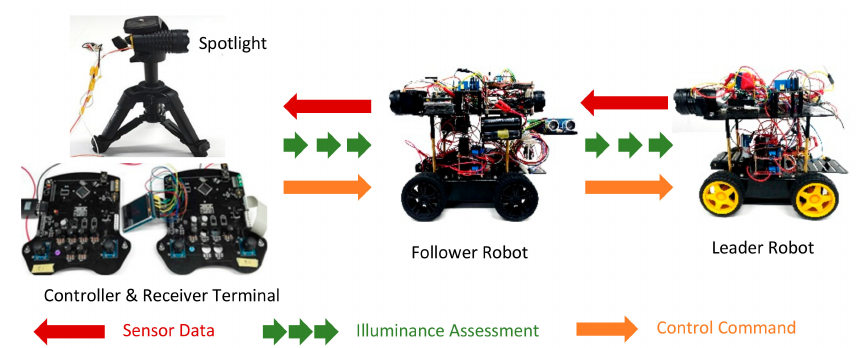
Figure 2. Whole architecture of the robot chain system.